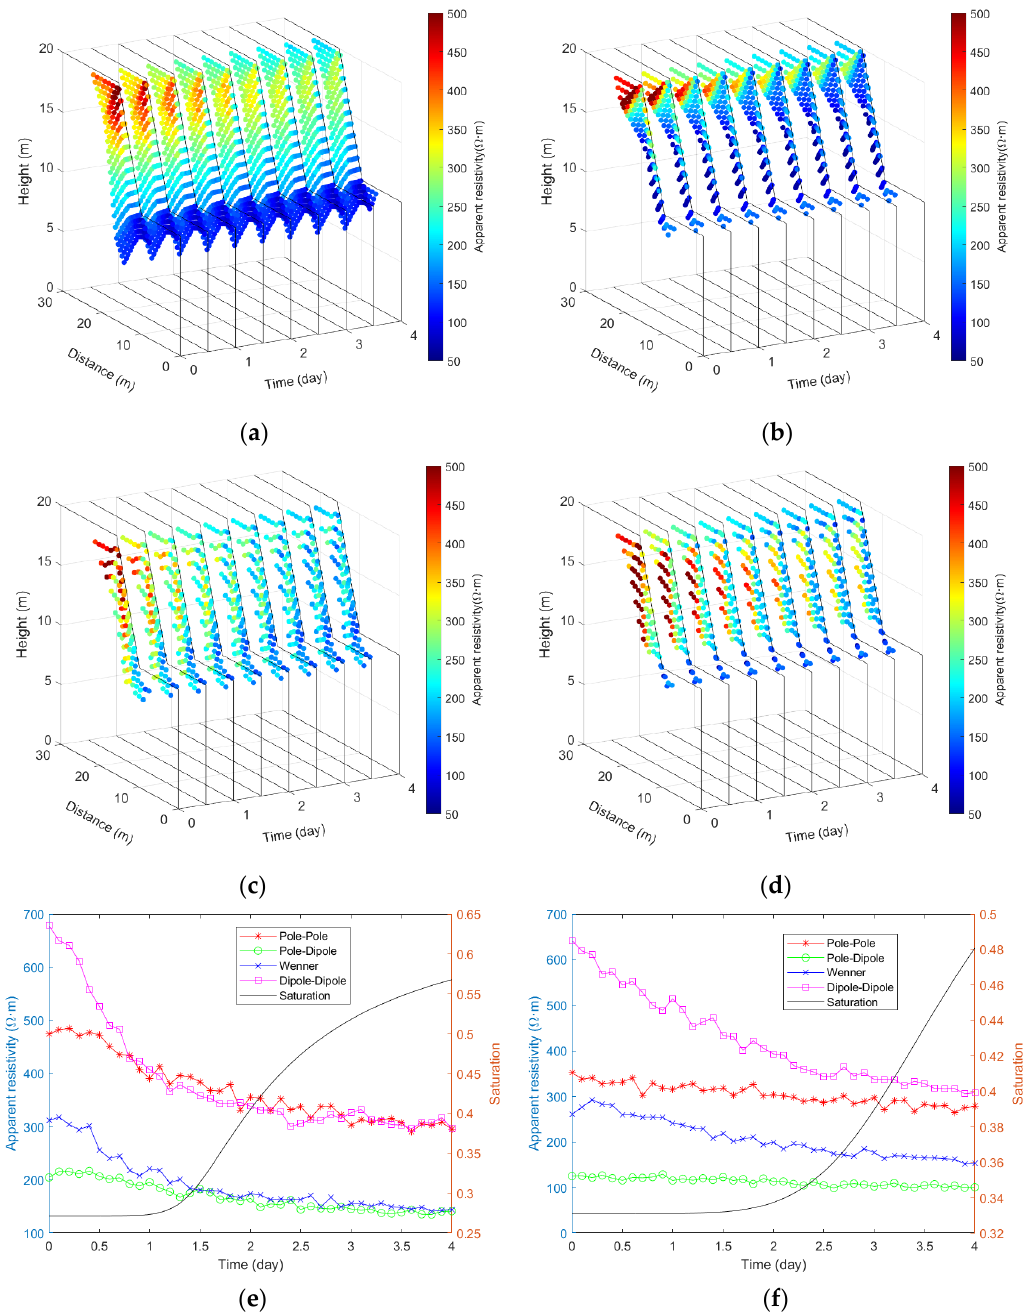
Figure 6. Apparent resistivity response with 3% Gaussian noise of various arrays during rainfall: ( a ) Pole-Pole array; ( b ) Pole-Dipole array; ( c ) Wenner array; ( d ) Dipole-Dipole array. ( e ) The evolution of apparent resistivity and saturation at point A with time. ( f ) The evolution of apparent resistivity and saturation at point B with time.